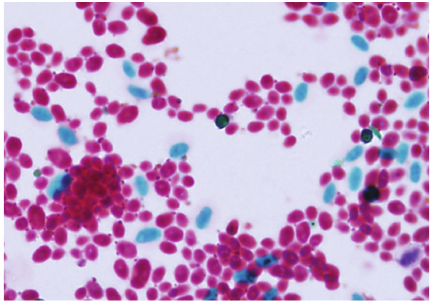
Figure 1: Ellipsoidal to elongate ascospores (green) of L. elongis- porus produced on cornmeal agar and stained with Schaeffer-Fulton stain. Magnification, × 1000.